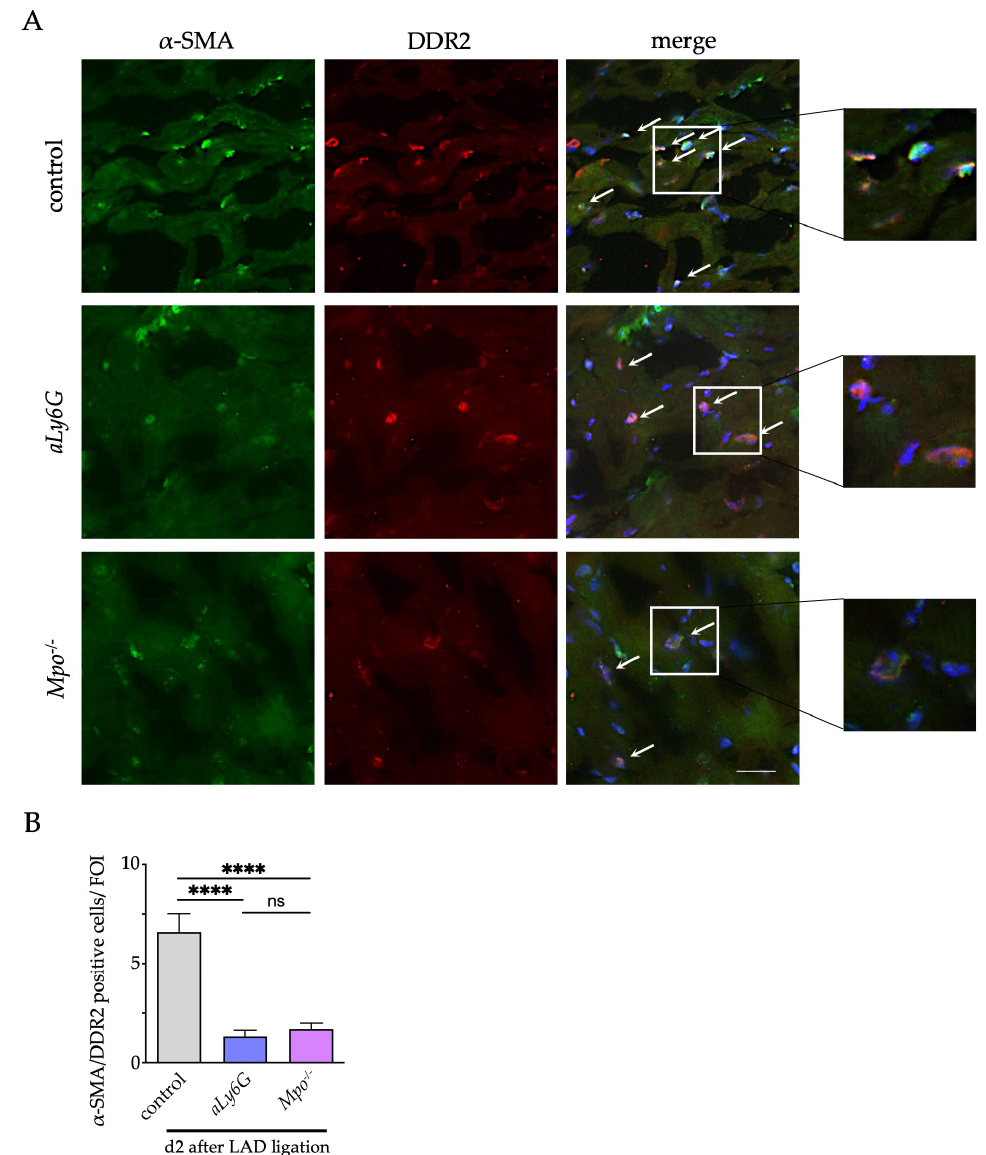
Figure 4. Myofibroblast transdifferentiation after MI. ( A ) Representative immunofluorescence stain- ings of murine cardiac sections 2 days after PI for the fibroblast marker discoidin domain-containing receptor 2 (DDR-2; green) and the myofibroblast marker α –smooth muscle actin ( α -SMA; red) (blue = DAPI; scale bar = 100 µ m). Arrows indicate double positive cells. ( B ) Quantification of myofi- broblasts within the infarct and peri-infarct region. n = 5/5/5; **** p < 0.0001, ns = not significant; one way ANOVA test followed by appropriate post hoc test, mean ± SEM is